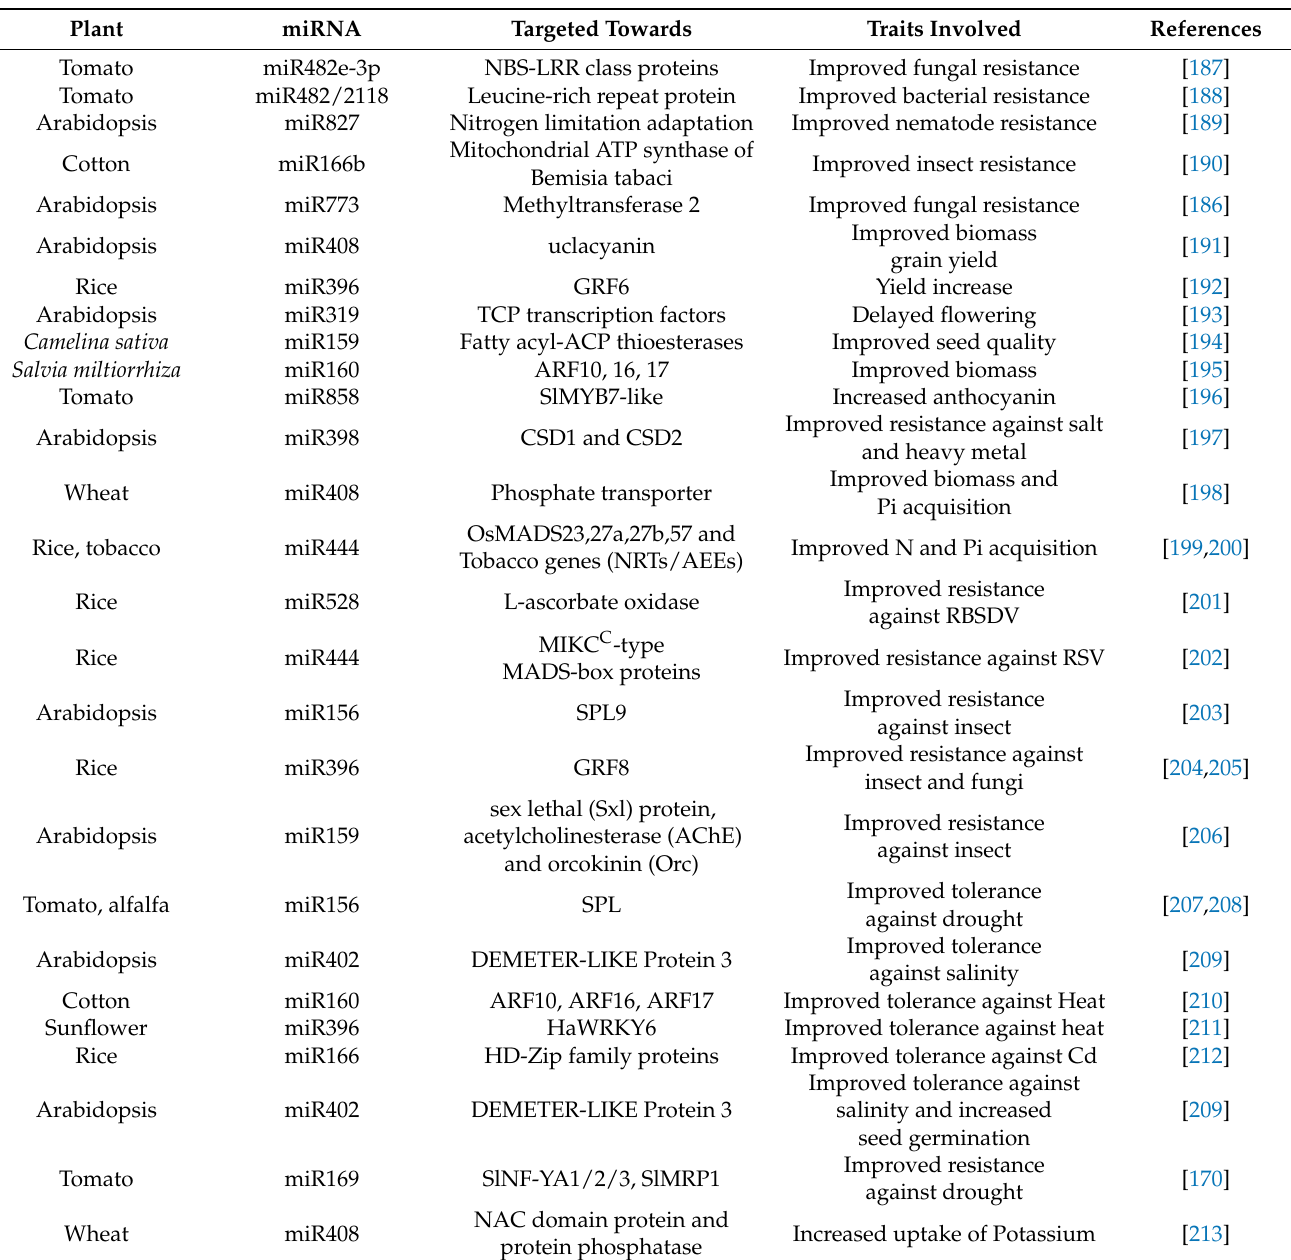
Table 4. Genetic alteration of miRNAs in plants to improve the desirable